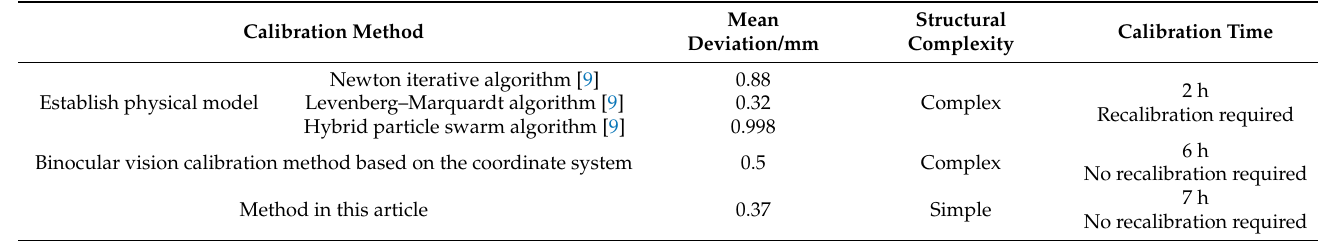
Table 3. Comparison of accuracy and convenience of different calibration